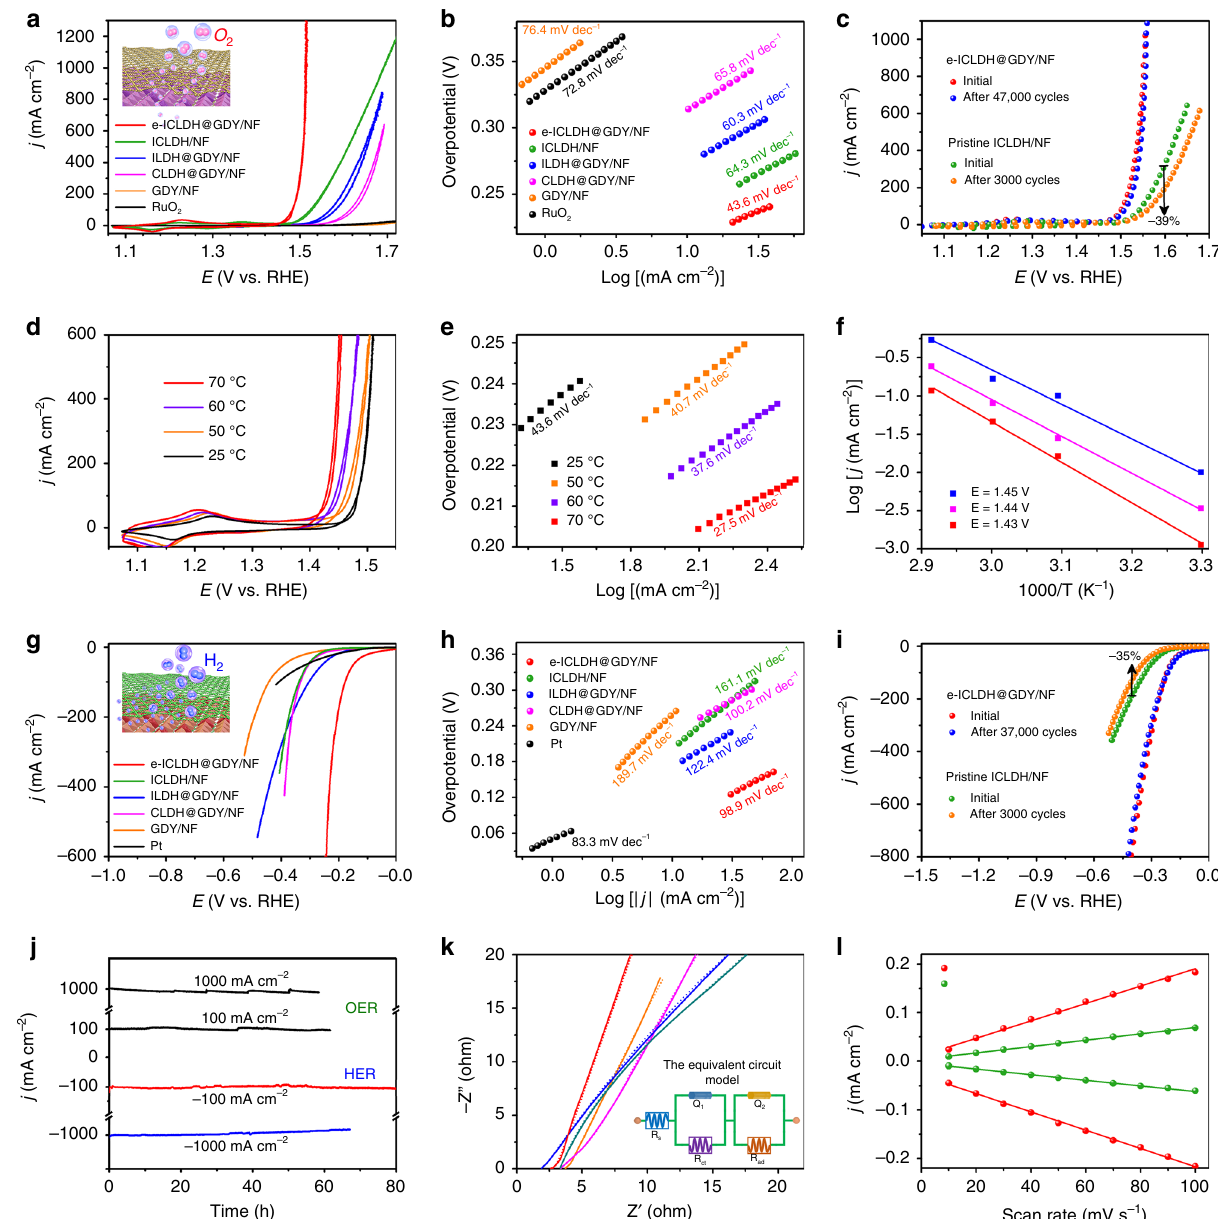
Fig. 6 Electrocatalytic performance of e-ICLDH@GDY/NF. a OER CV curves and b corresponding Tafel plots of as-synthesized samples. c Polarization curves of e-ICLDH@GDY/NF and pristine ICLDH/NF, recorded before and after performing 47,000 and 3000 cycles, respectively, of the OER. d OER CV curves and e corresponding Tafel plots for e-ICLDH@GDY/NF, recorded at various temperatures. f Arrhenius plots for the OER performed over e- ICLDH@GDY/NF at various potentials. g HER polarization curves and h corresponding Tafel plots for the as-synthesized samples. i HER polarization curves of e-ICLDH@GDY/NF and pristine ICLDH/NF, recorded before and after 37,000 and 3000 cycles, respectively, of the HER. j Chronopotentiometric curves of e-ICLDH@GDY/NF recorded at 100 and 1000 mA cm – 2 for both the OER and HER. k Experimental (solid line) and fi tted (dashed line) Nyquist plots for e-ICLDH@GDY/NF (red), ICLDH/NF (green), ILDH/NF (blue), CLDH/NF (magenta), and GDY/NF (orange), respectively; inset: equivalent circuit model. l Capacitive current densities at 0.818 V, plotted with respect to the scan rate, for e-ICLDH@GDY/NF (red) and ICLDH/NF